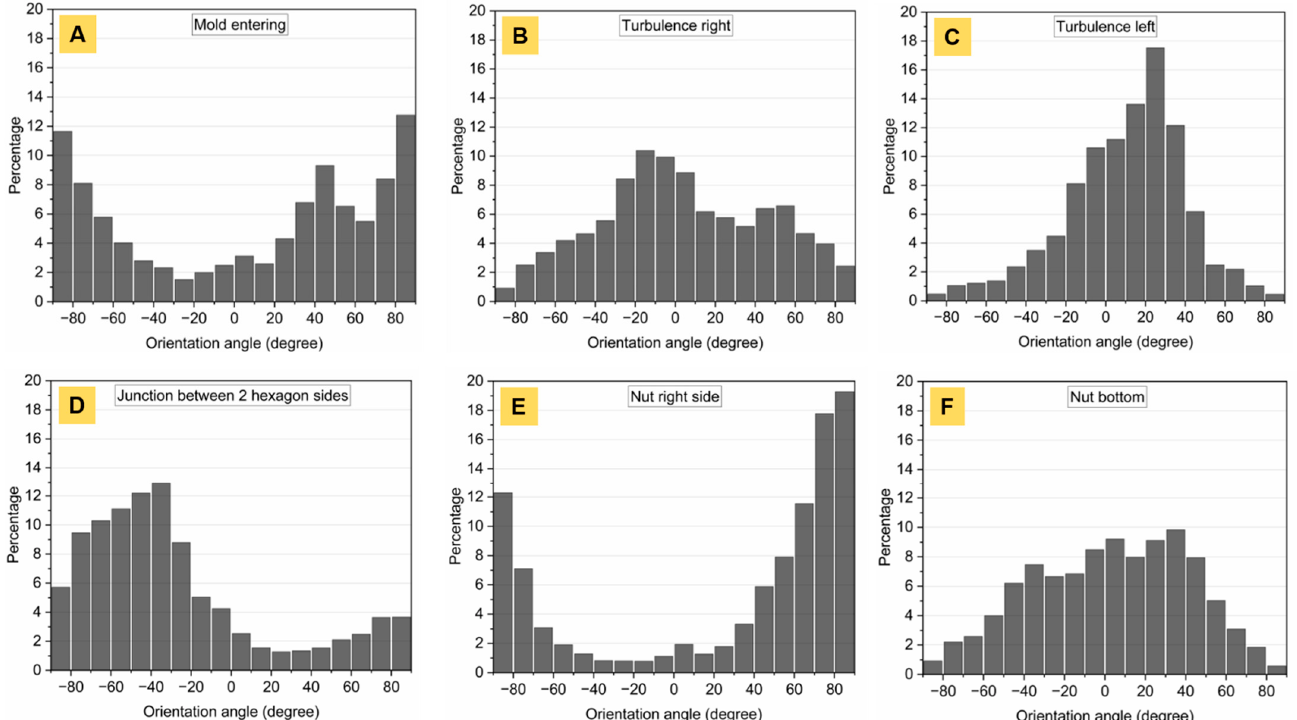
Figure 9. Fiber orientation distribution (FOD) in a 20 vol.% fiber-reinforced Ti 2 AlC hexagonal nut for corresponding areas in Figure 8: ( A ) at the mold entering, ( B ) in the right turbulence, ( C ) in the left turbulence, ( D ) at the junction between two hexagon sides, ( E ) in the right side of the nut and ( F ) in the bottom of the nut.